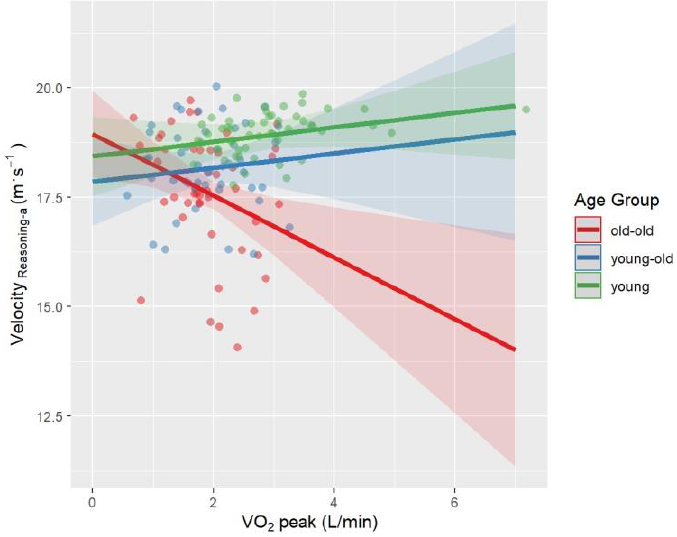
Figure 2. Interaction effect between age and VO 2 peak on Velocity Reasoning-a after controlling for BMI and sex. The fit lines represent the trend of the data for subgroups. Green: young adults, Blue: young-old adults, Red: old-old adults. Young and young-old adults with a higher VO 2 peak drove faster, while old-old adults drove slower.